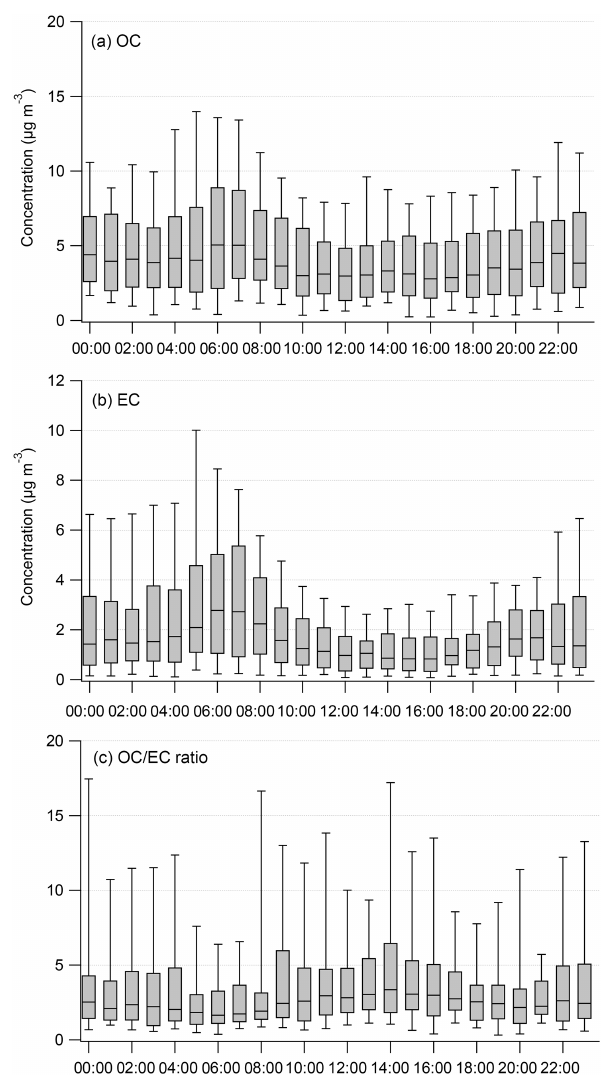
Figure 5. Diurnal variation of (a) OC, (b) EC, and the (c) OC / EC ratio. The boxes represent the interquartile range and the upper and lower whiskers represent 90 and 10%, respectively.